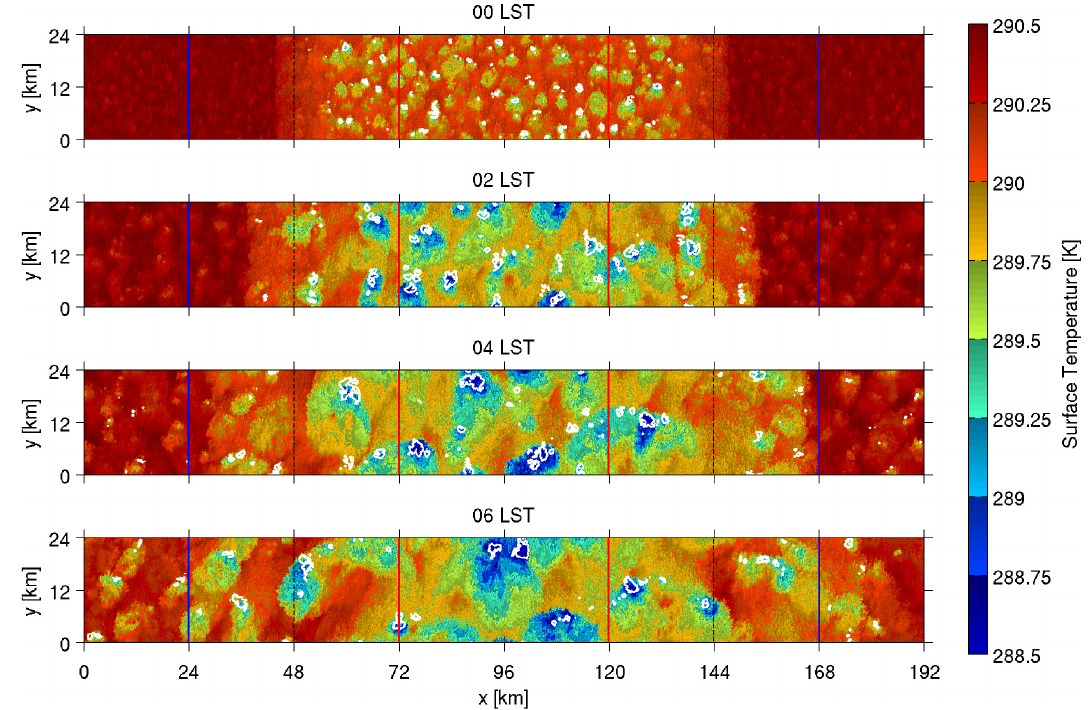
= 0 . 01 g kg − 1 contour overlaid c